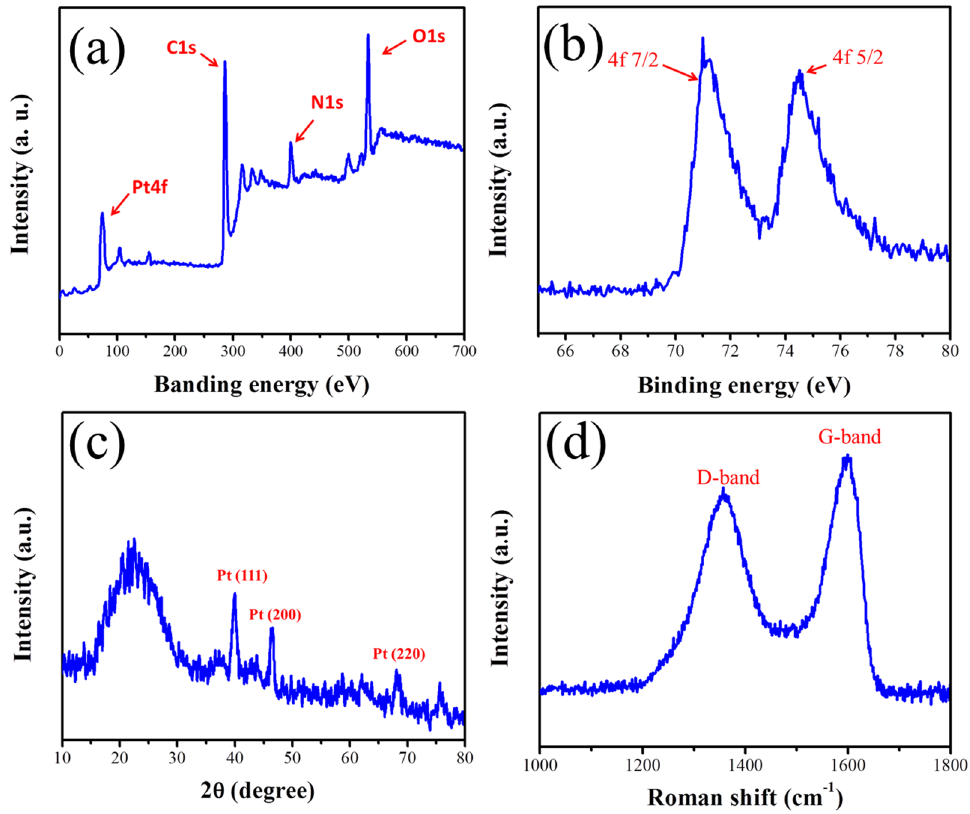
Figure 6. Characterization of electrospun CNF-PtNP hybrids: ( a , b ) X-ray photoelectron spectroscopy (XPS) spectra; ( c ) Power X-ray diffraction (XRD) pattern; and ( d ) Raman